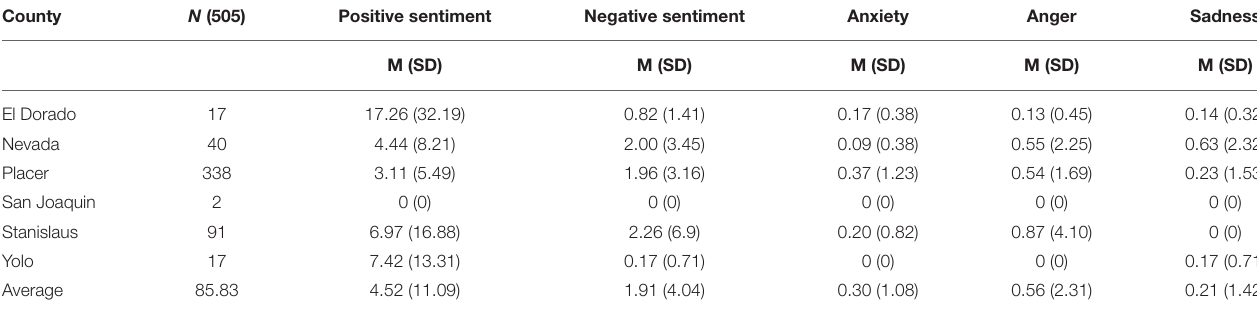
TABLE 3 | Average sentiments and negative emotions of public Facebook comments about the HPV vaccine. County N